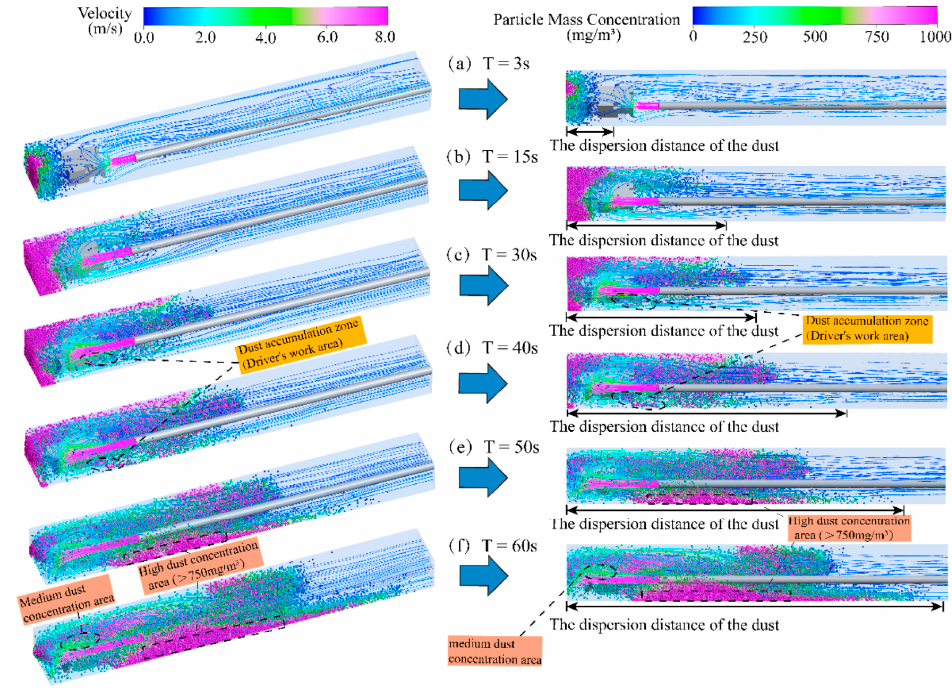
Figure 13. Dust distribution in tunneling at different diffusion times (Standard tunneling model). (1) A 1.5 m-diameter circle of dust with a high concentration of more than 1000 mg/m 3